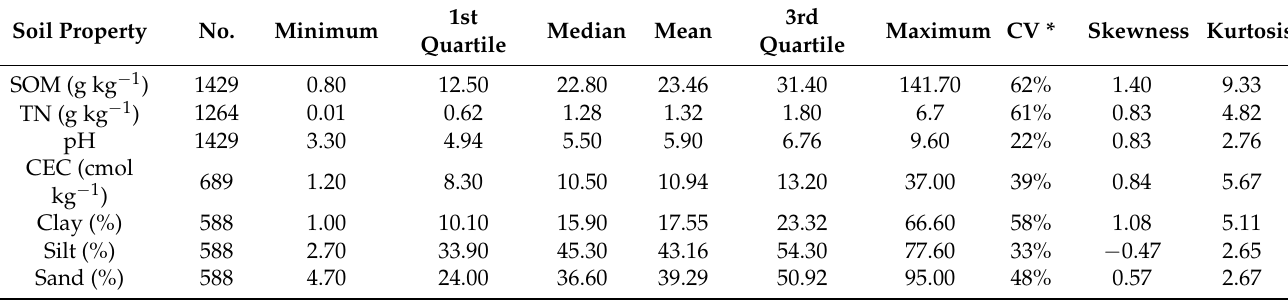
Table 2. Statistics of soil properties in the